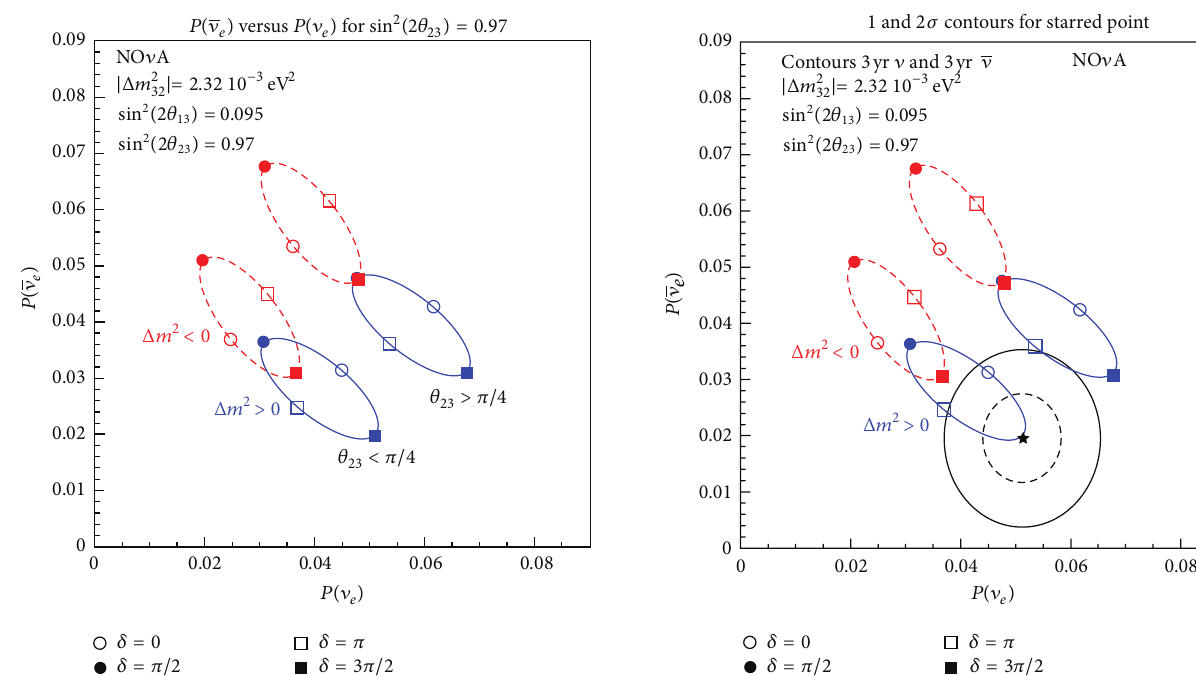
Figure 28: Biprobability plot for sin 2 (2𝜃 23 ) = 0.97 with NO 𝜈 A expected 1 and 2 standard deviation contours superimposed on the starred point.